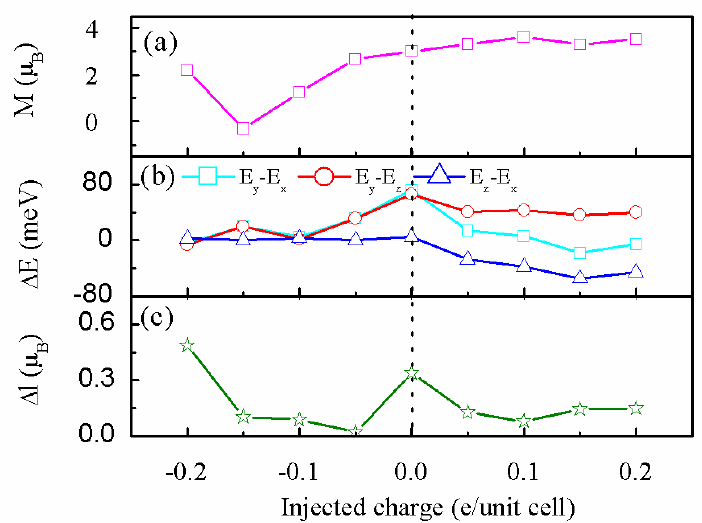
Figure 3. Injected charge dependence of ( a ) magnetic moment and ( b ) energy difference between each magnetization direction. ( c )The difference in orbital magnetic moment between easy and hard magnetization directions for Re of Re@NDV. The charge-doping scale (in units of e/unit cell) is referred to as the neutral system. Positive (negative) values stand for an excess (lack) of valence